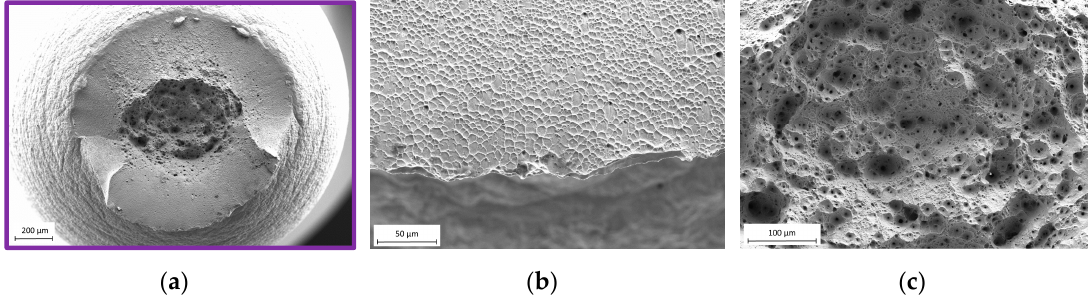
Figure 8. Fracture surface of the inert SSRT at 80 °C: ( a ) ductile appearance over the whole fracture surface and visible deformation lines on the outer surface of the sample, ( b ) pure ductile structure at the edge of the sample, ( c ) deep dimples at the centre of the fracture surface.